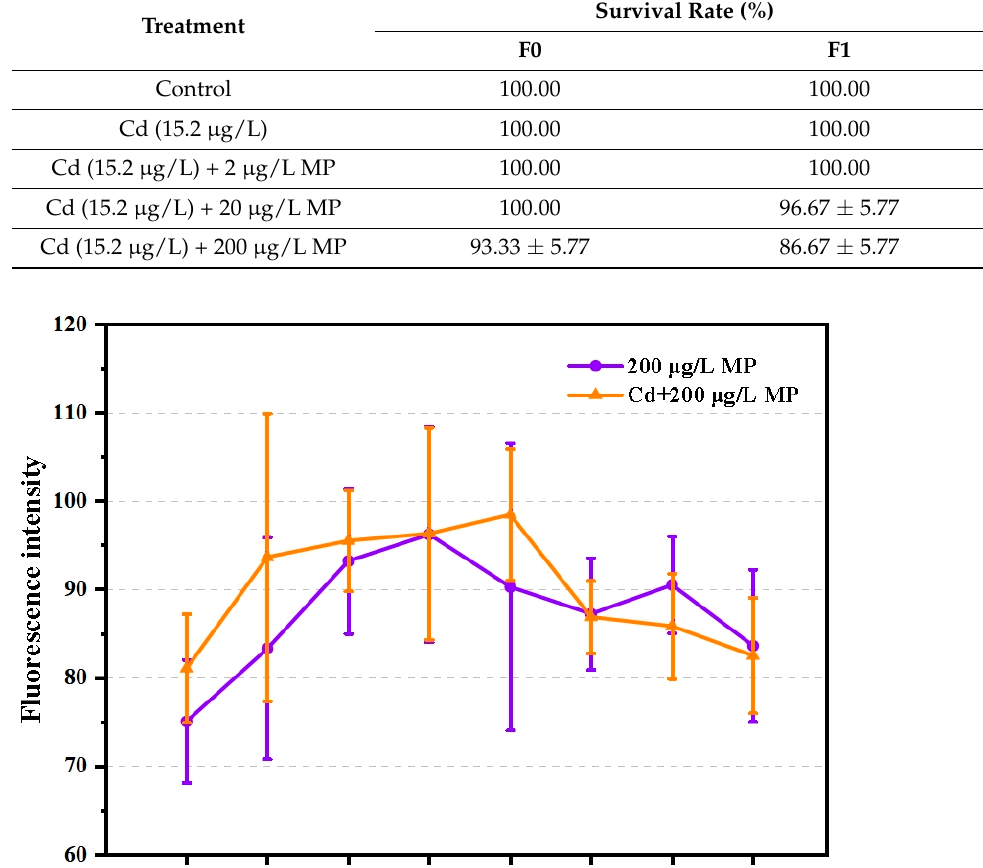
Table 1. Survival rate of T. japonicas in F0 and F1 generation exposed to Cd and PS-microplastic ( n = 10). Treatment